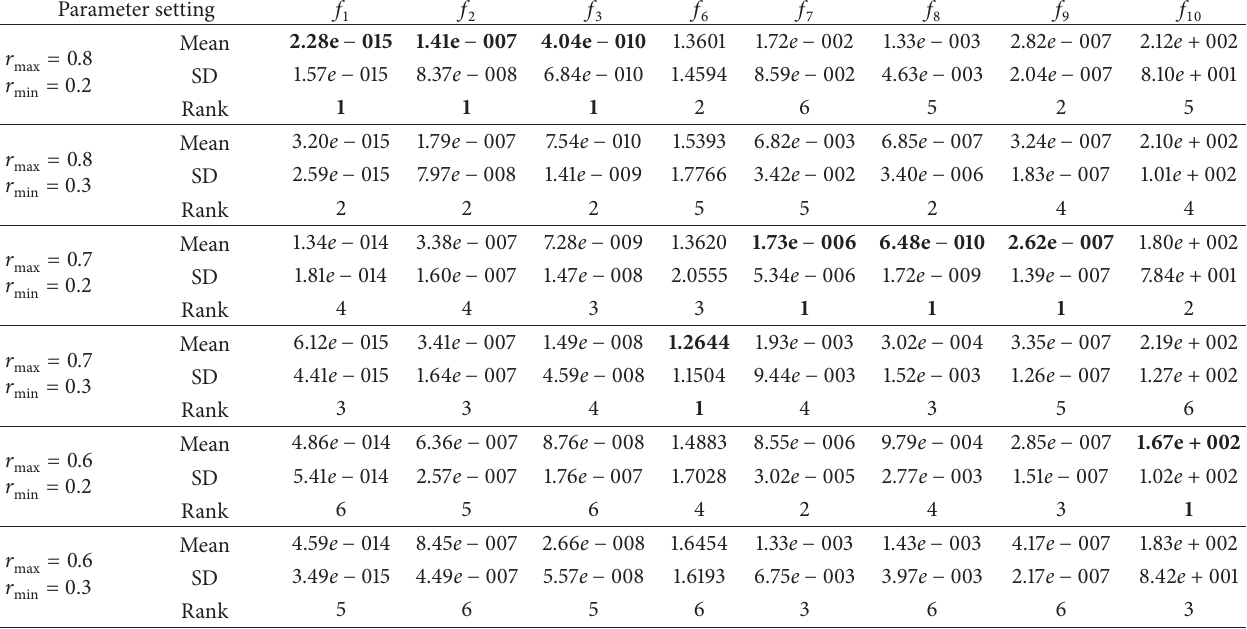
Table 1: Experimental results of different combination of 𝑟 max and 𝑟 min in LTVS.